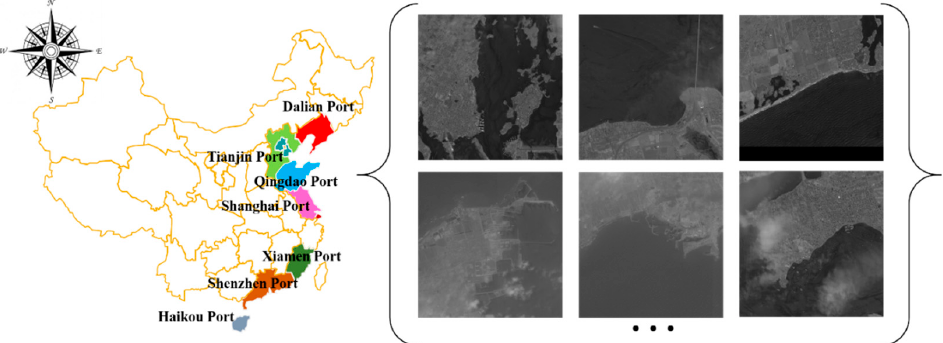
Figure 3. Study area of famous Chinese ports: Dalian, Tianjin, Qingdao, Shanghai, Xiamen, Shenzhen, and Haikou ports, All SOPT 5 and GF-2 data were collected from these famous ports.